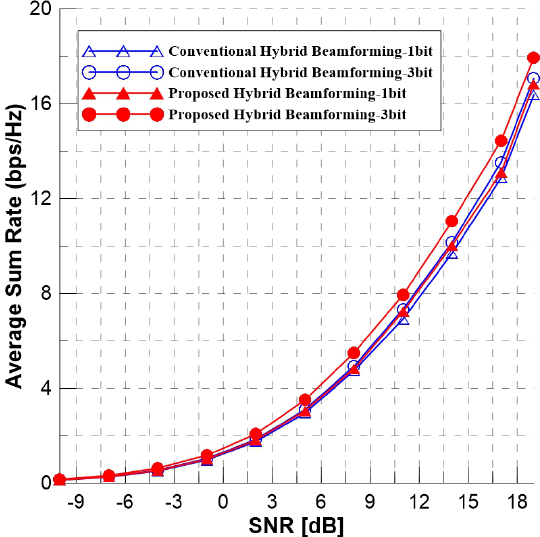
Figure 11. The average sum rate of the hybrid beamforming schemes, N t = 16.